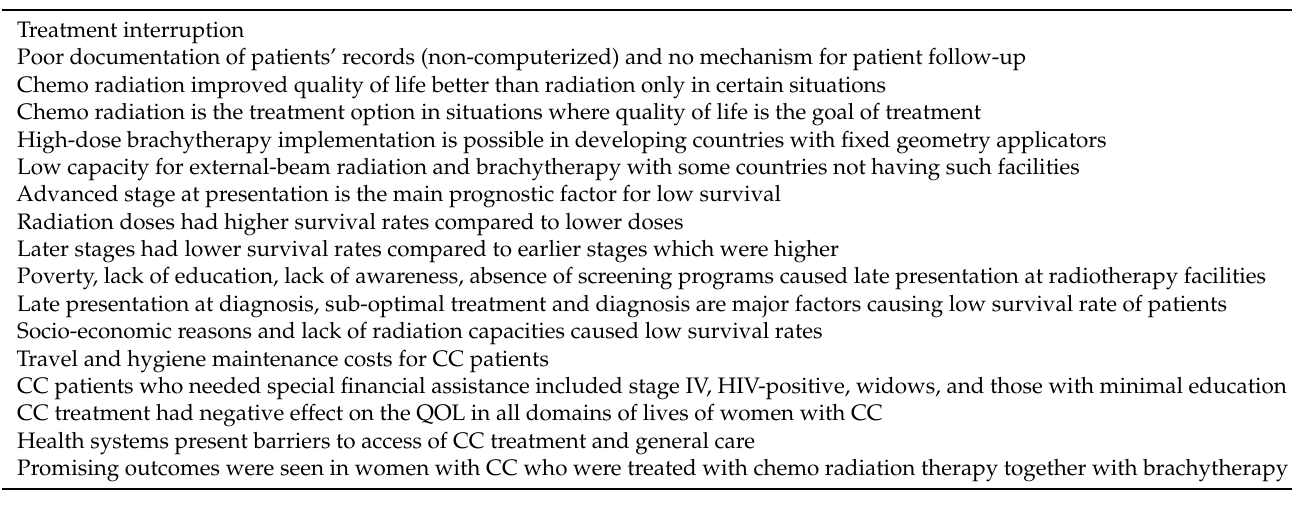
Table 5. Radiotherapy status in